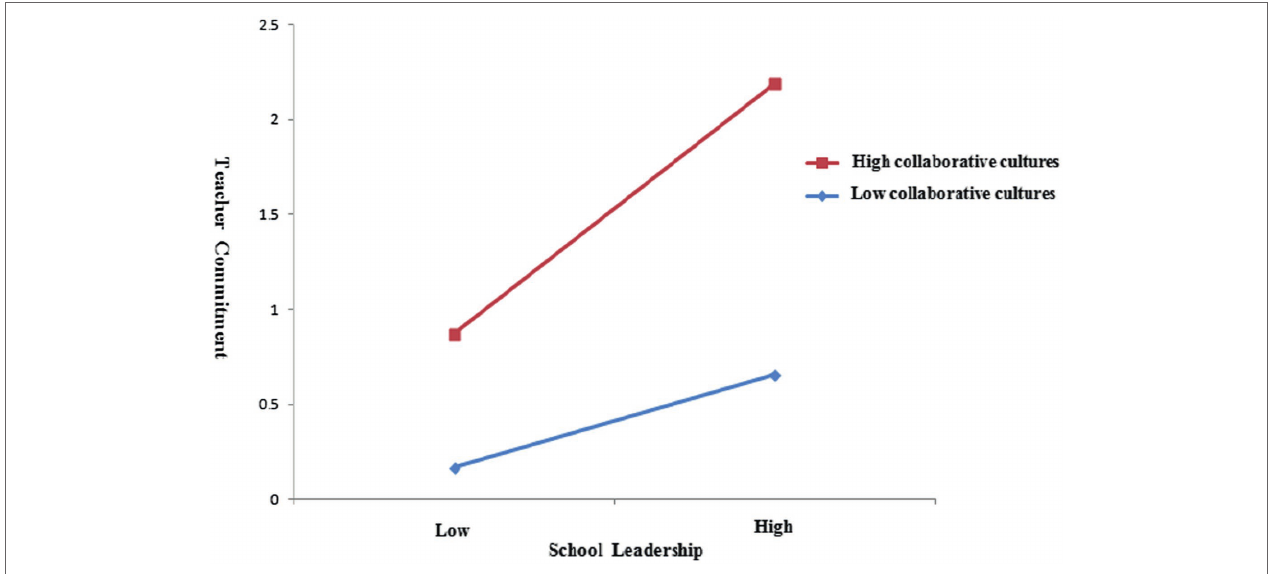
FIGURE 3 | Interaction between SL and CC with regard to